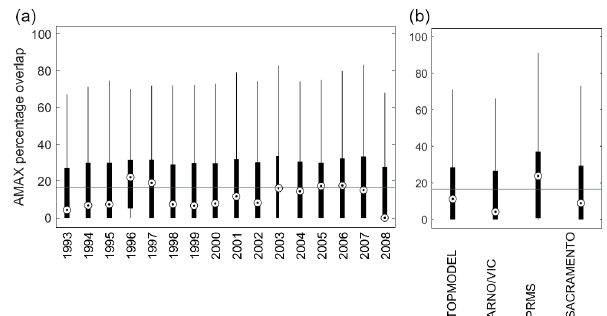
Figure 12. Predictive capability of four hydrological models for an- nual maximum (AMAX) flows across Great Britain. Boxplots show the overlap of the simulated and observed uncertainty bounds, as a percentage of the total uncertainty. This metric ranges from 0 to 100, with 0 indicating no overlap between observed and simu- lated AMAX discharge and 100 indicating a perfect overlap of ob- served and simulated discharge bounds. The range in the (a) is over all catchments and all models, whilst (b) shows the range across all